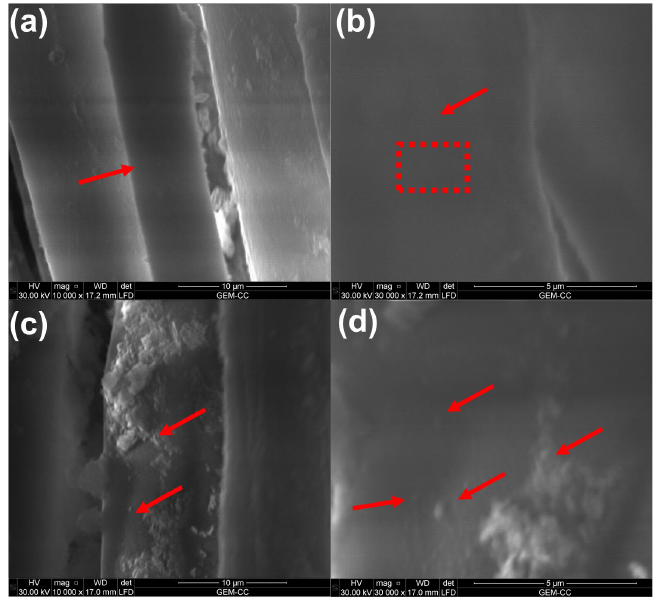
Figure 3. SEM image of ( a ) untreated cotton hand embroidery threads of sample 1 and ( b ) the corresponding high-magnification image, and ( c ) treated cotton hand embroidery threads of sample 1-T and ( d ) the corresponding high-magnification image displaying the rough surface.